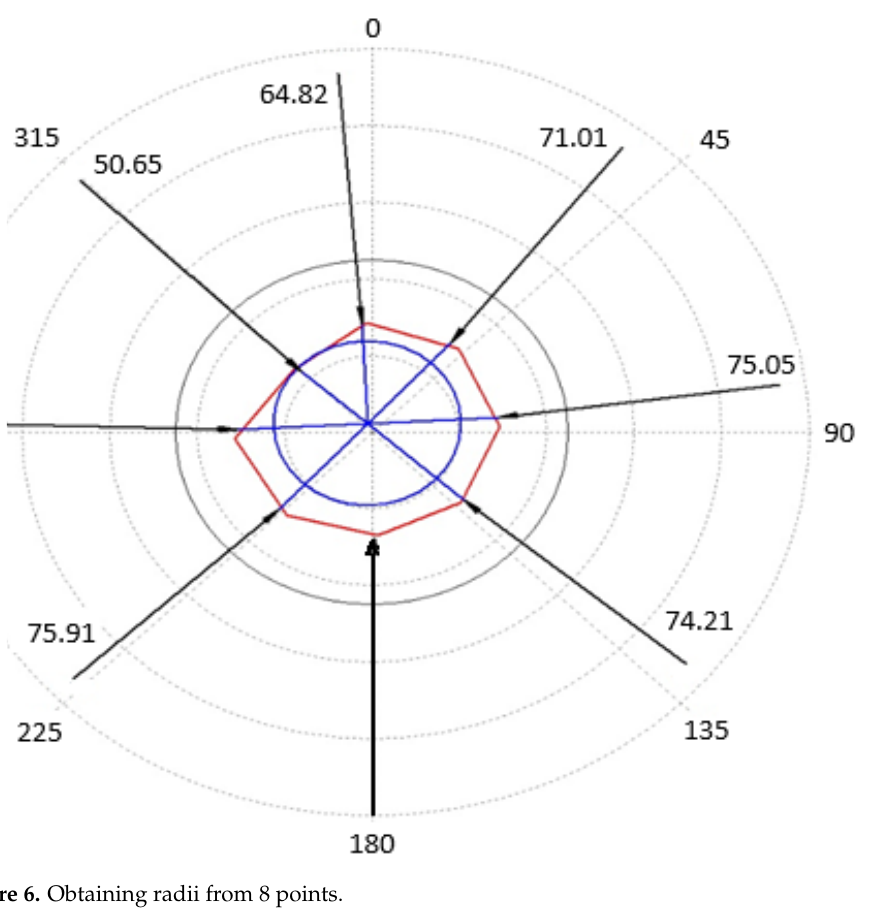
Figure 6. Obtaining radii from 8 points. The blue contour shows the position of the lowered tool relative to the walls of the well, and the red contour is the profile of the well obtained by eight sensors by means of wave reflection.